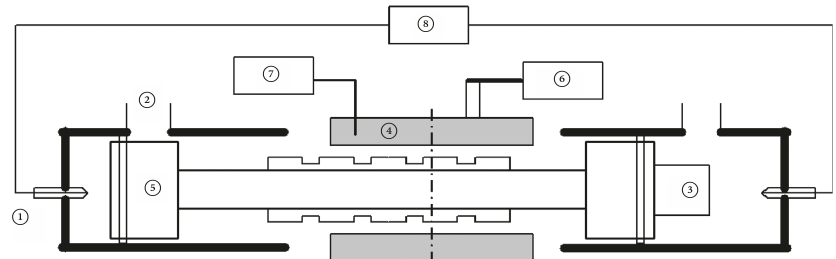
Figure 1: The structural type of the FPDEG prototype. (1) Fuel injector; (2) exhaust; (3) scavenge; (4) linear motor; (5) free piston; (6) electromagnetic load; (7) motor mode conversion controller; (8) fuel injection controller.